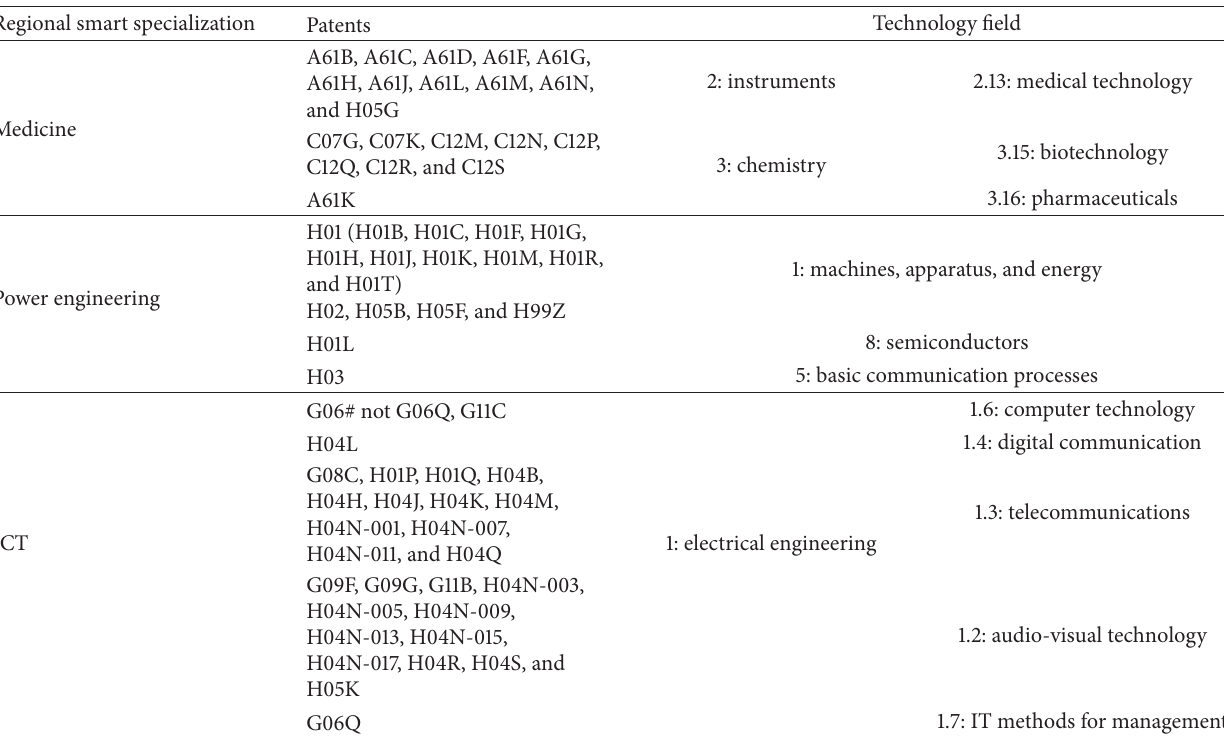
Table5:Listofpatentsrelatedtothetechnologyfieldsoftheregionalsmartspecializationinmedicine,powerengineering,andICT,according to the WIPO classification [15] (the first